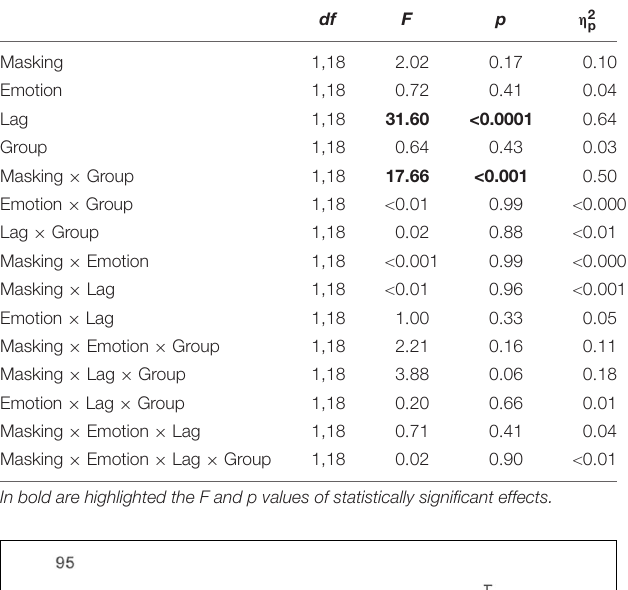
slightly reduced hit rate compared to neutral faces. The joined TABLE 3 | ANOVA results Experiment 2.